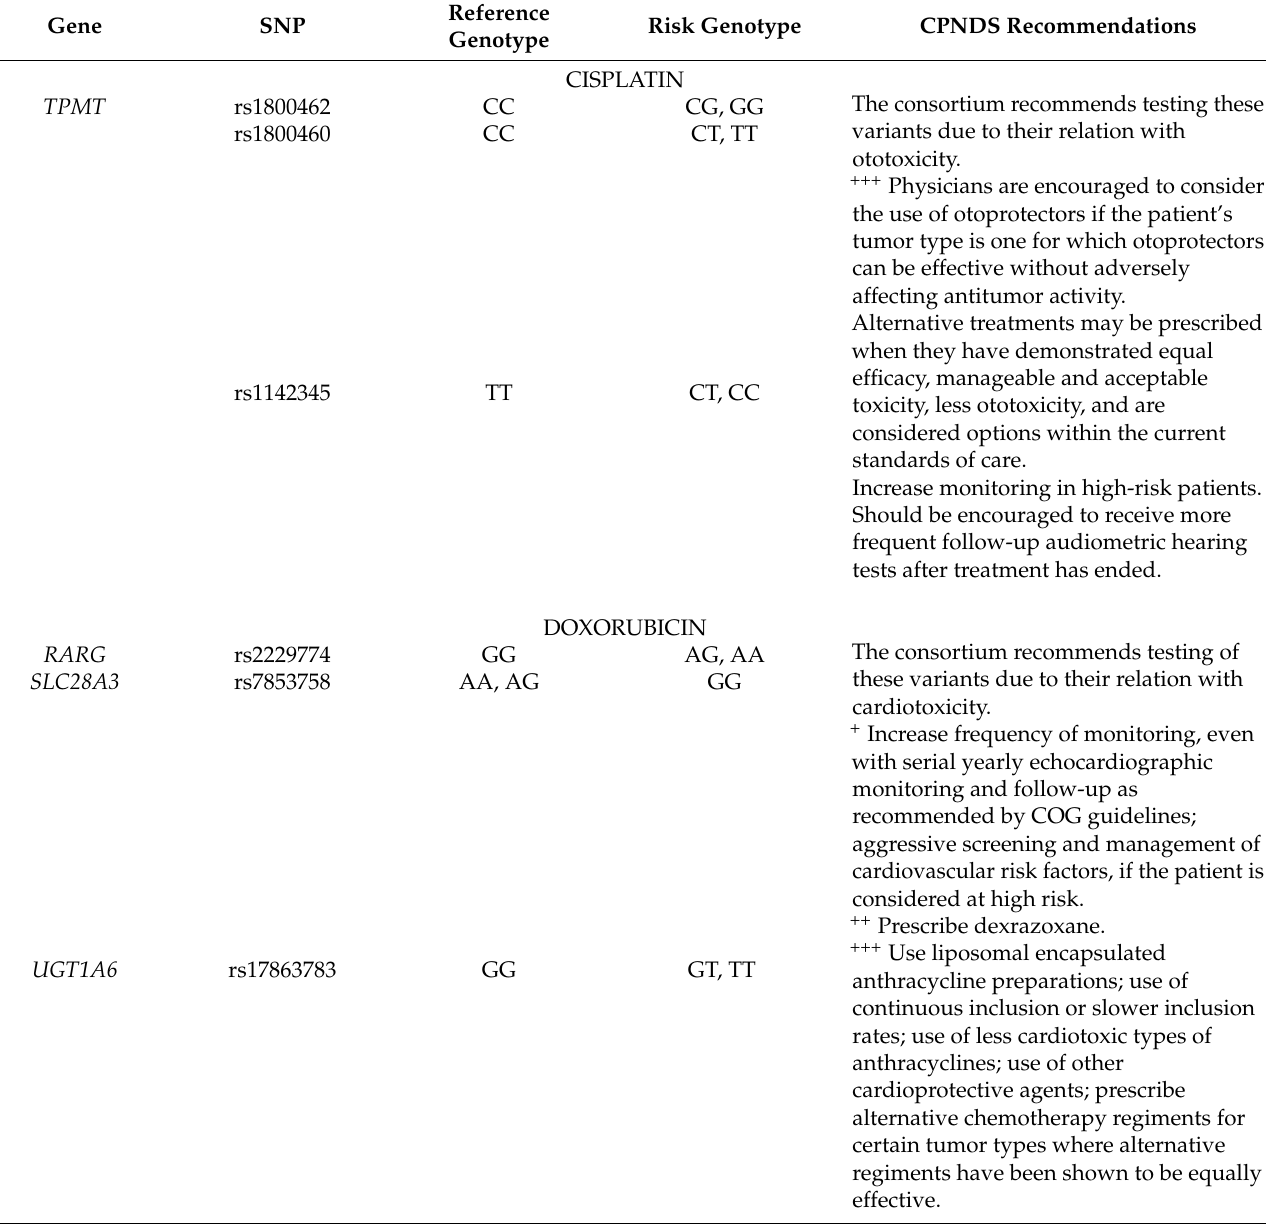
Table 2. Summary of recommendations provided in the CPNDS guidelines for cisplatin and doxorubicin.